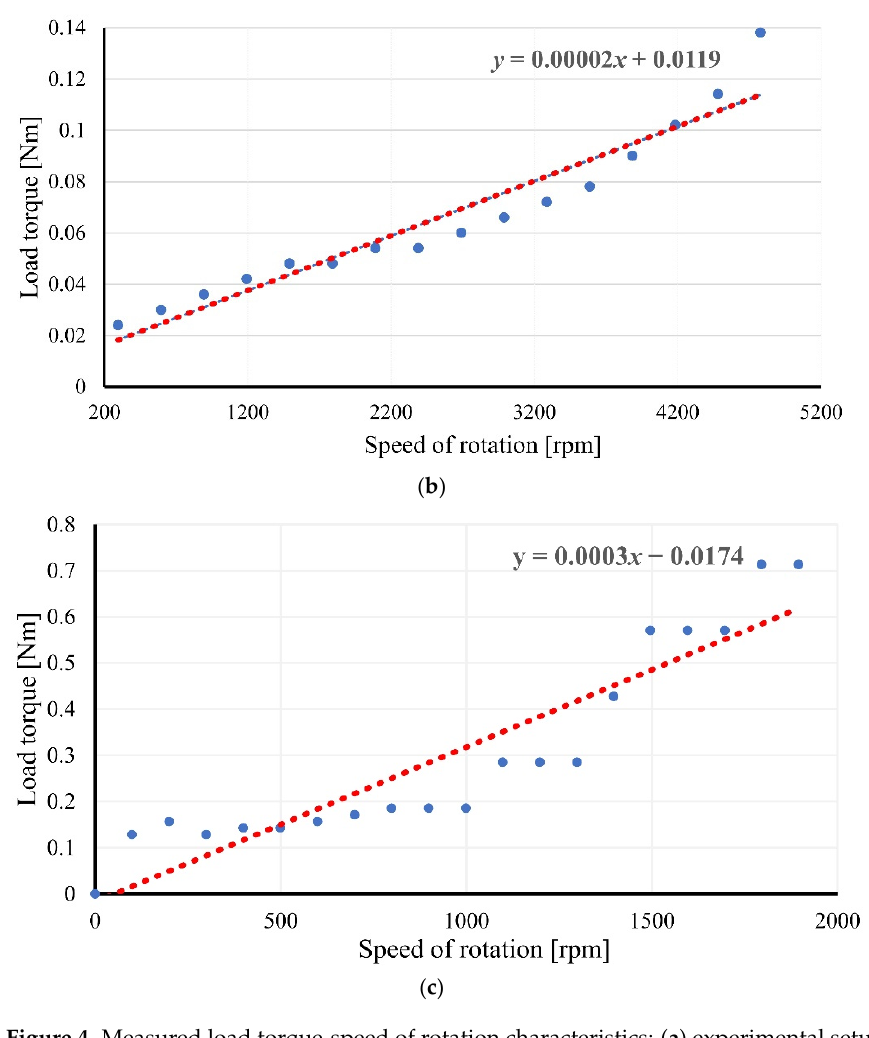
Figure 4. Measured load torque-speed of rotation characteristics: ( a ) experimental setup, ( b ) IM#1, and ( c ) IM#2.